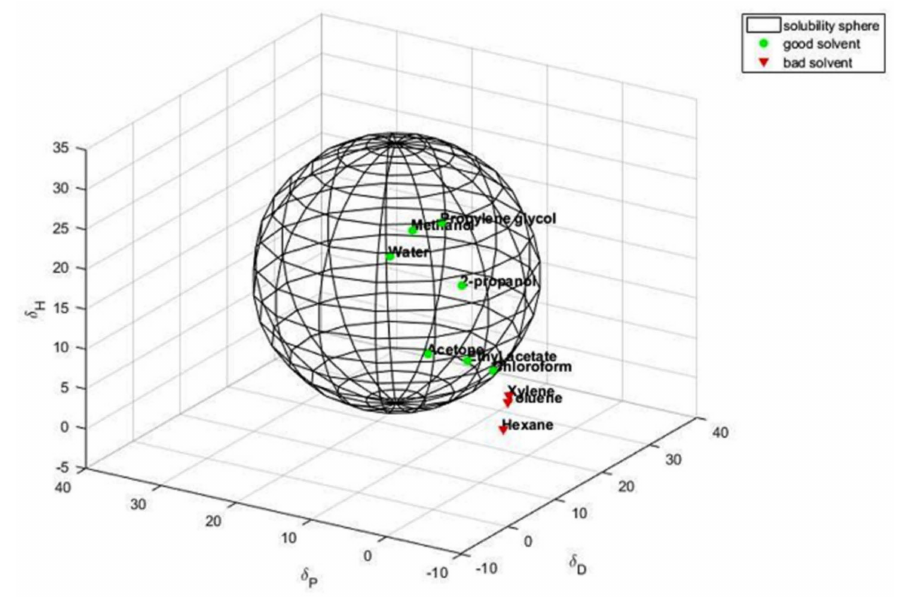
Figure 2. Hansen solubility sphere calculated for G-OH. The green circles correspond to the good solvents (within the radius of interaction), the red triangles to the bad solvents (outside the sphere). Polar protic and aprotic solvents such as water, 2-propanol, and acetone are included in the G-OH interaction sphere, whereas the apolar solvents are outside of the sphere. With respect to HSAG, G-OH shows higher values of δ D and δ H